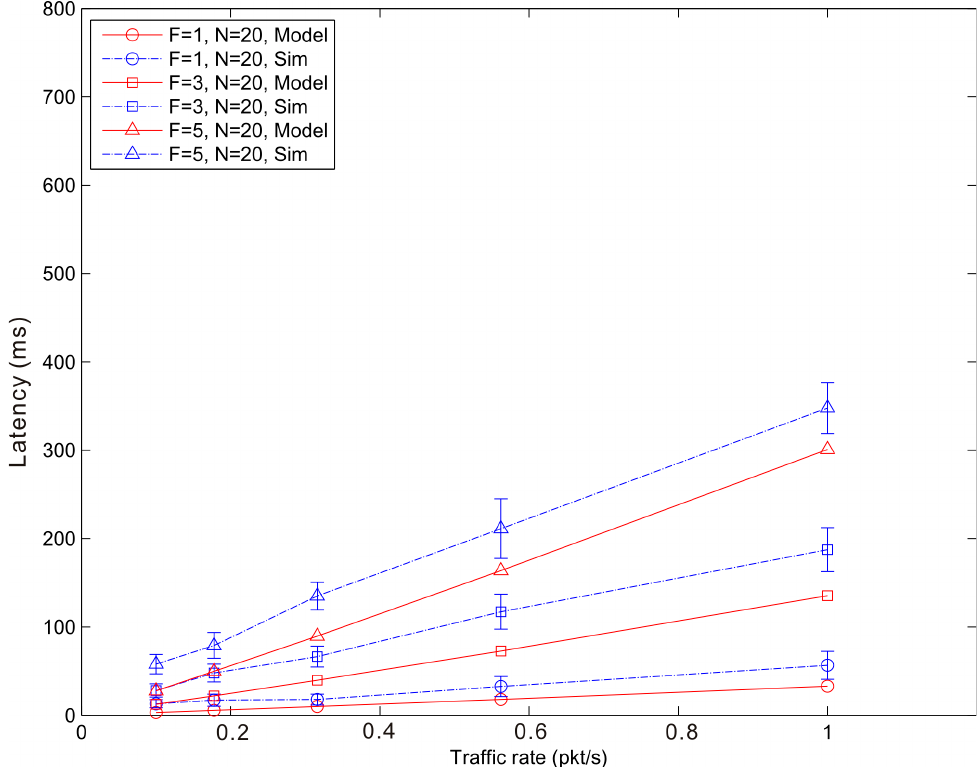
Figure 19. 6LoWPAN Fragmentation Latency versus traffic rate for a star topology network composed by 20